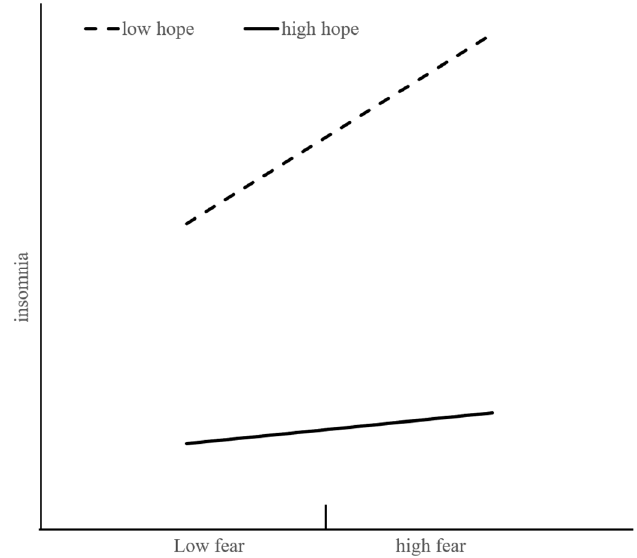
Figure 3. Hope as a moderator between fear of COVID-19 and insomnia. Thirdly, the SPSS PROCESS Macro (Hayes, 2013; Model 8) was used to investigate the mediated moderation effect. The results can be read form the table three. Fear of COVID-19 was positively related to depression ( β = 0.154, t = 2.769, and 95% CI = [0.045, 0.263]), and in- somnia was positively related to depression ( β = 0.635, t = 32.067, and 95% CI = [0.596, 0.674]). Meanwhile, the interaction of fear of COVID-19 and hope was not related to depression ( β = − 0.033, t = − 1.699, 95% CI = [ − 0.070, 0.005]). This means that the hypothesized mediated moderation model was validated ( β = − 0.060, 95% CI = [ − 0.093, − 0.028]), and the moderating effect of hope was completely mediated by insomnia. The mediating effect of insomnia was 0.042, 95% CI = [0.027, 0.057]. The confidence interval of the mediating effect does not contain zero, meaning that the mediating effect is significant in our